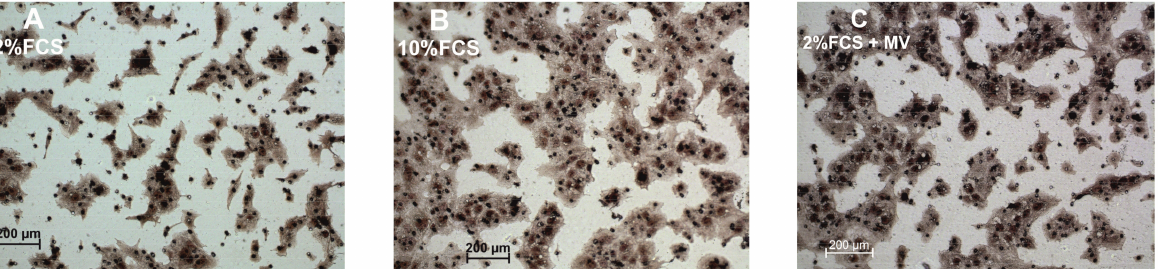
Figure 1. Migration of JEG-3 cells in the presence of: ( A ) DMEM medium supplemented with 2% FCS (spontaneous level); ( B ) DMEM supplemented with 10% FCS; ( C ) DMEM supplemented with 2% FCS and MV cells of NK-92 line. Slides were stained with Mayer’s hematoxylin, magnification 100 ×